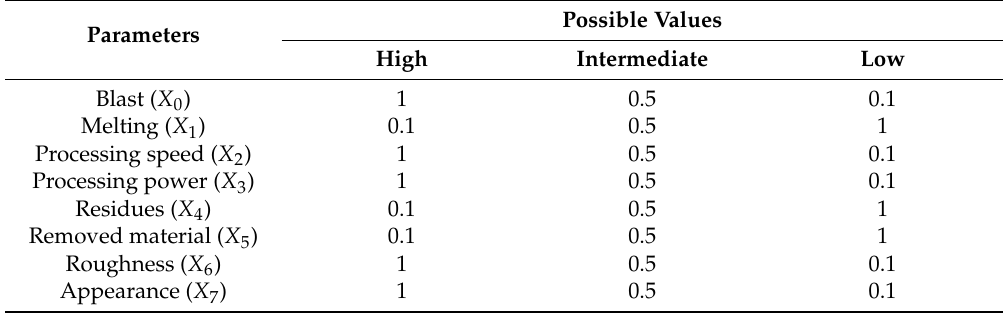
Table 2. Possible values of those parameters involved in the definition of the quality of the laser blasted